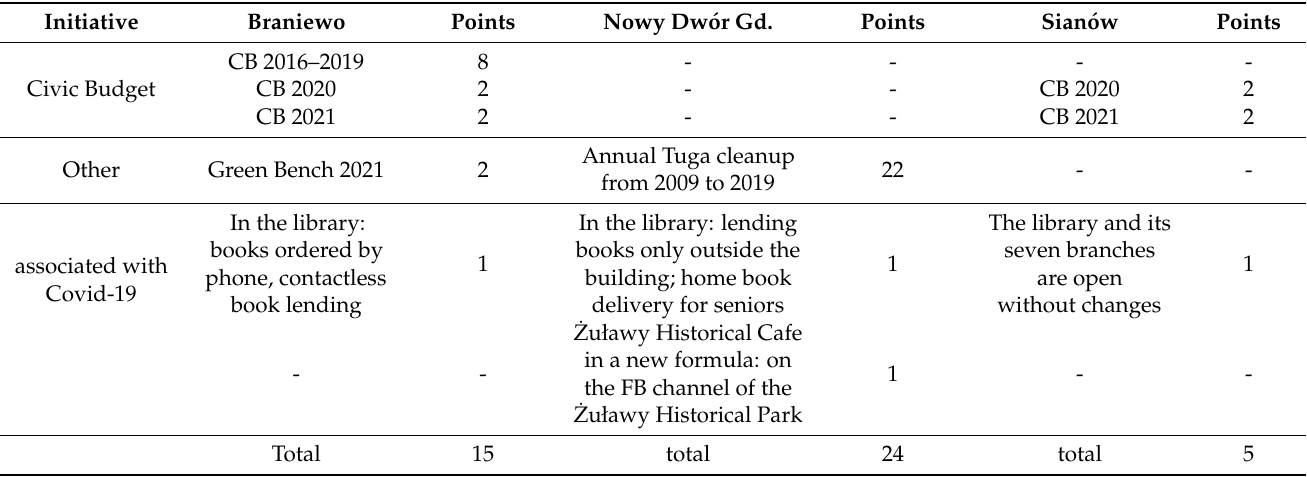
Table 9. A list of initiatives serving to build the relationships between residents and their towns, with the score assigned. Initiative Braniewo Points Nowy Dw ó r